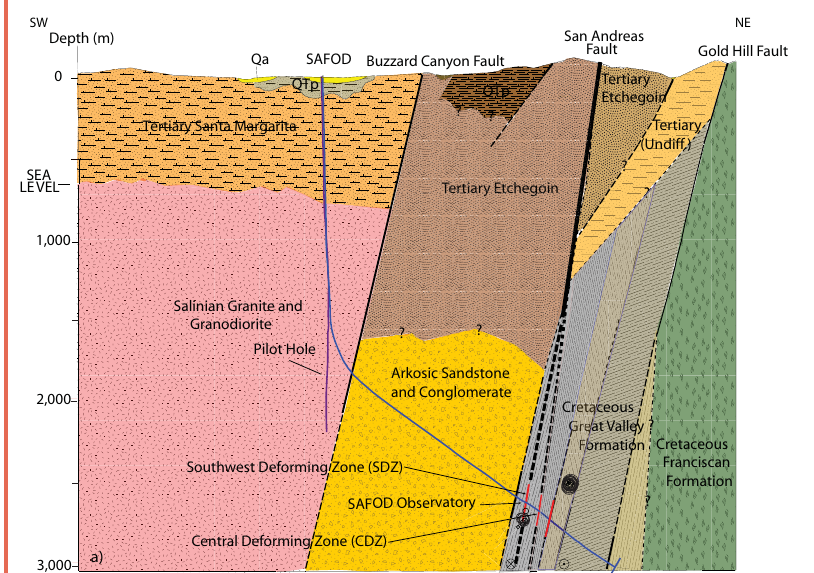
Figure 1. Diagram showing the location of both active traces of the San Andreas Fault that were spot-cored in 2007. Modified from Zoback et al., 2010.